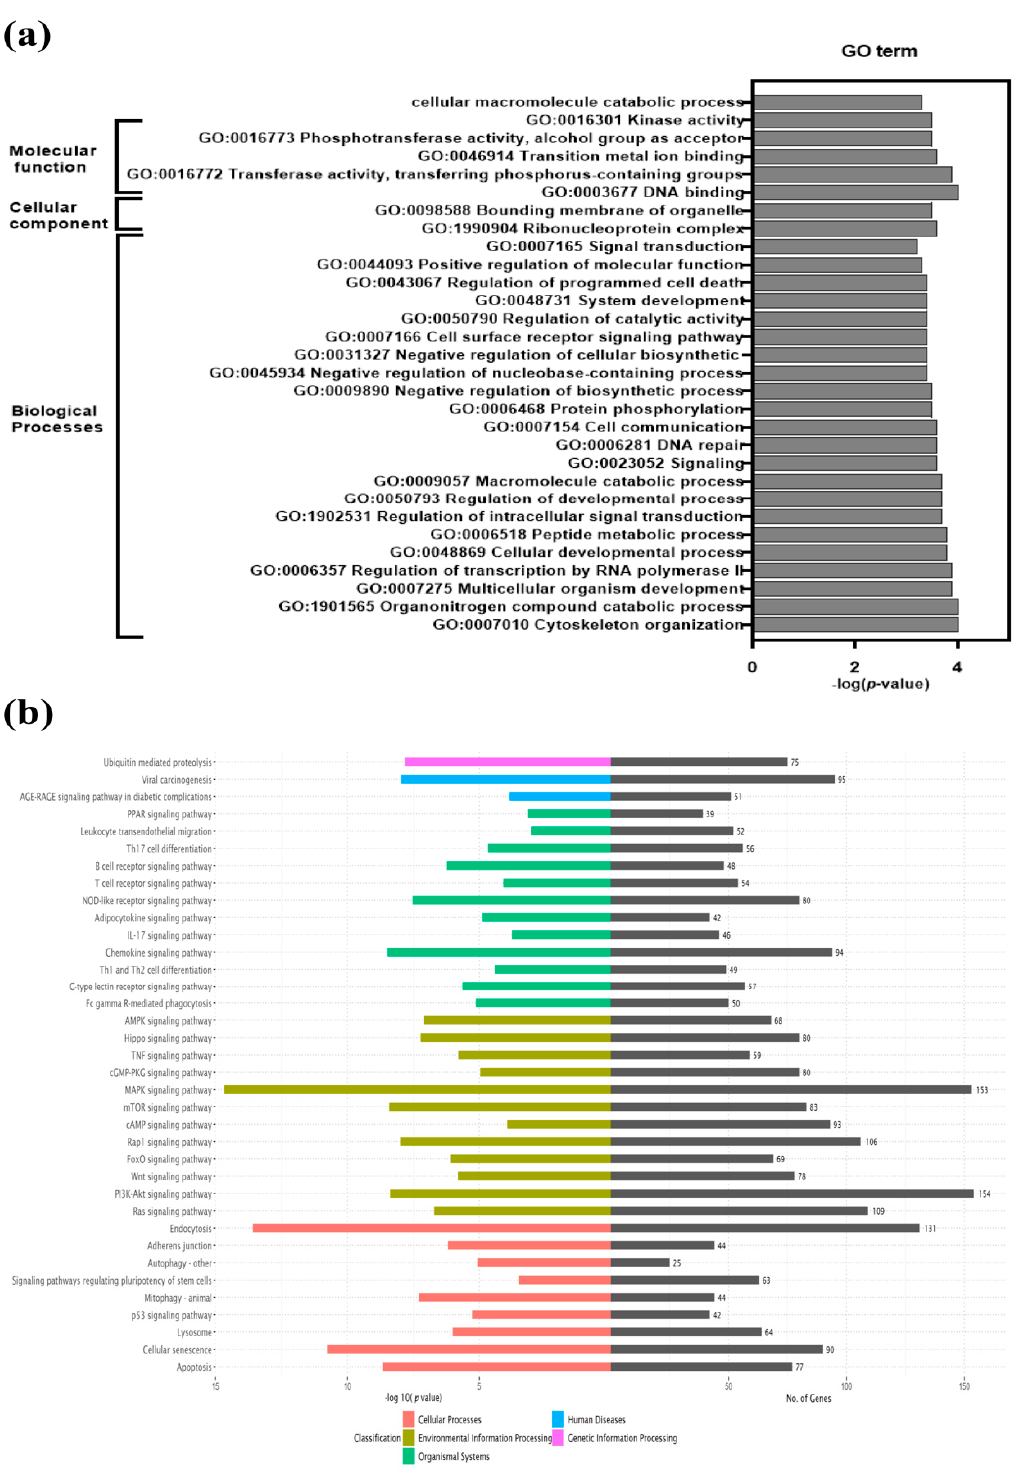
Figure 3. Gene Ontology (GO) enrichment and Kyoto Encyclopedia of Genes and Genomes (KEGG) pathway analysis of differentially expressed genes (DEGs). ( a ) GO analysis of DEGs at 46 dpi. Top 30 most significant GO categories p -value < 0.05 are shown; ( b ) KEGG pathway enrichment analysis was performed for DEGs. The graph depicts the top 36 overrepresented KEGG pathways. Pathways showing, p -value < 0.05 are considered statistically significantly overrepresented. The left side indicates the enrichment score ( p -value) while the right side of the graph indicates the number of genes in the respective pathways.